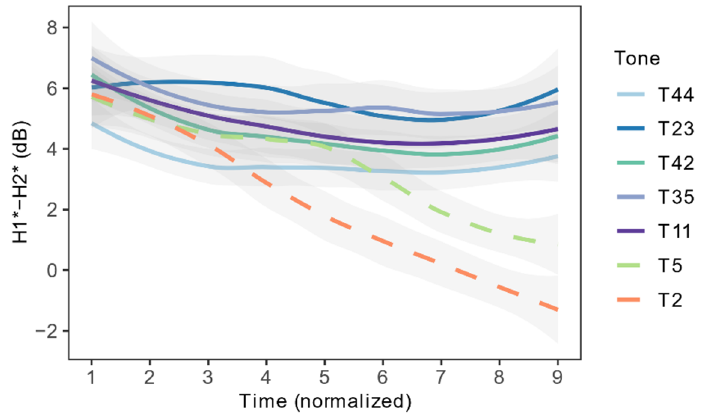
Figure 5. Average H1*–H2* track of the seven tones in Xiapu